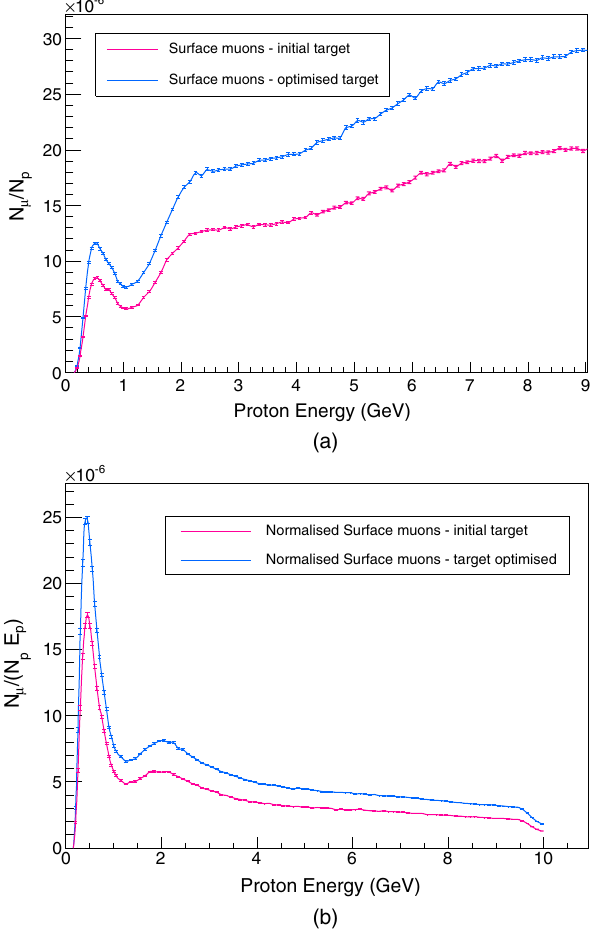
FIG. 9. Variation of surface muon yield with proton energy for the current ISIS target parameters and the optimized slab target design. (a) Muon multiplicity. (b) Muon yield per unit energy of incident